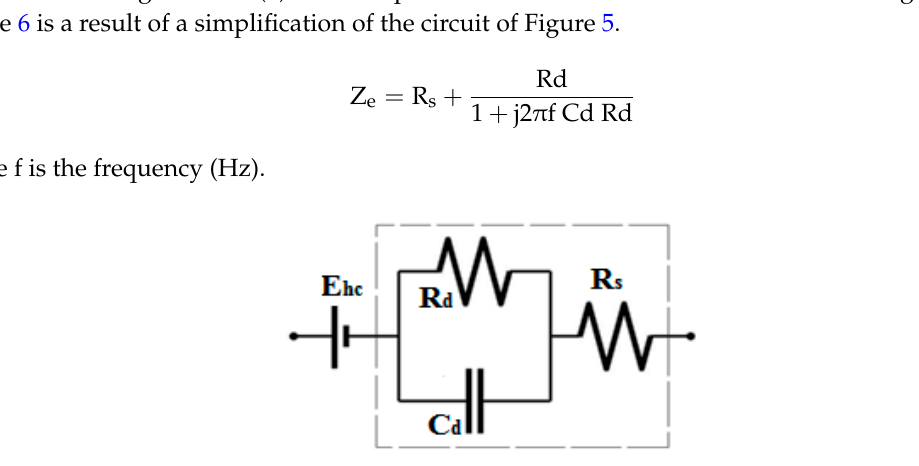
Figure 6. Equivalent circuit model for electrode-skin interface.